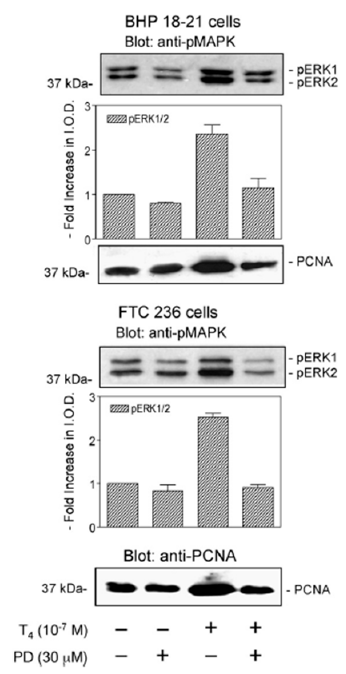
Figure 2. Proliferative activity of T4 in vitro on differentiated human papillary (BHP 18-21; upper panel) and follicular (FTC 236: lower panel) thyroid carcinoma cells. Proliferation was measured by immunoblotting of proliferative cell nuclear antigen (PCNA) from cultured cells. The 2.5-fold increase in PCNA in both cell lines was achieved with 10 -7 M total T4 concentration (10 -10 M free T4 in medium) [17]. The proliferative effect of the hormone required activation of ERK1/2 (MAPK). Inhibition of activation of ERK1/2 with PD98059 (PD) prevented enhancement of proliferation in both cell lines. T4 activates MAPK via the thyroid hormone analogue receptor on the extracellular domain of plasma membrane integrin α v β 3 [8,17]. Reprinted with permission from Elsevier from Lin et al. [16]. ERK1/2, extracellular signal-regulated kinases 1 and 2; MAPK, mitogen-activated protein kinase.